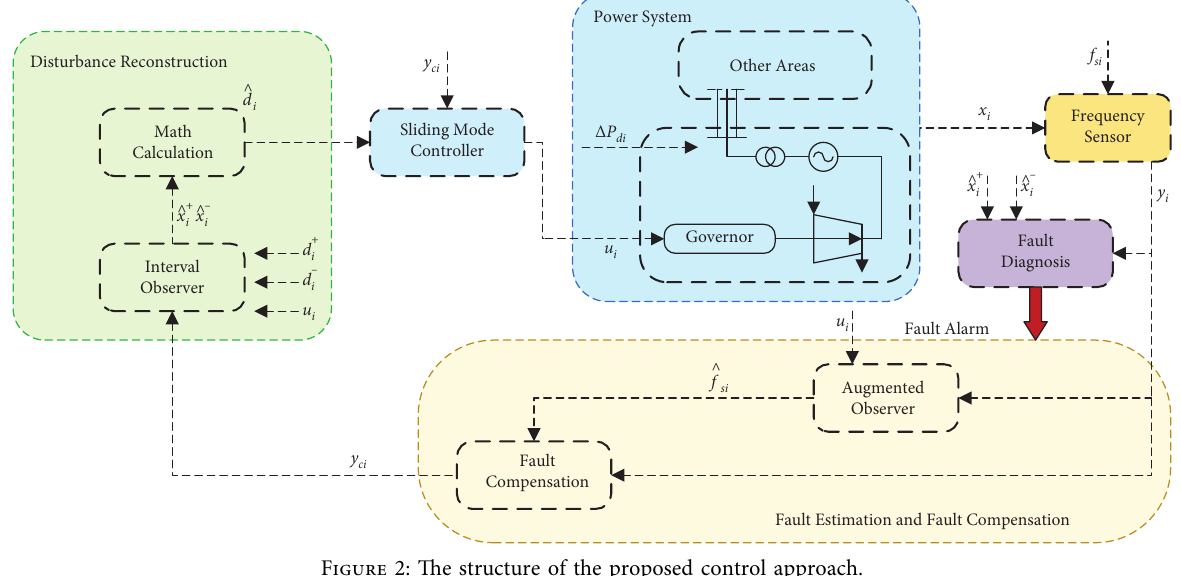
Figure 2: The structure of the proposed control